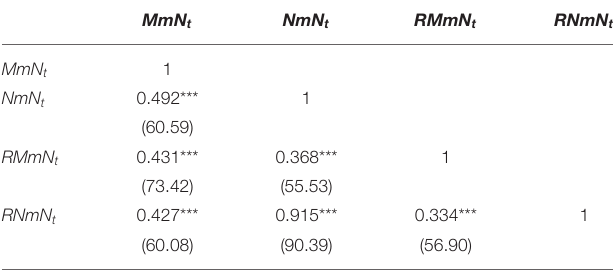
TABLE 2 | The correlation matrix for the four types of news. TABLE 3 | The mutual information matrix for the four types of